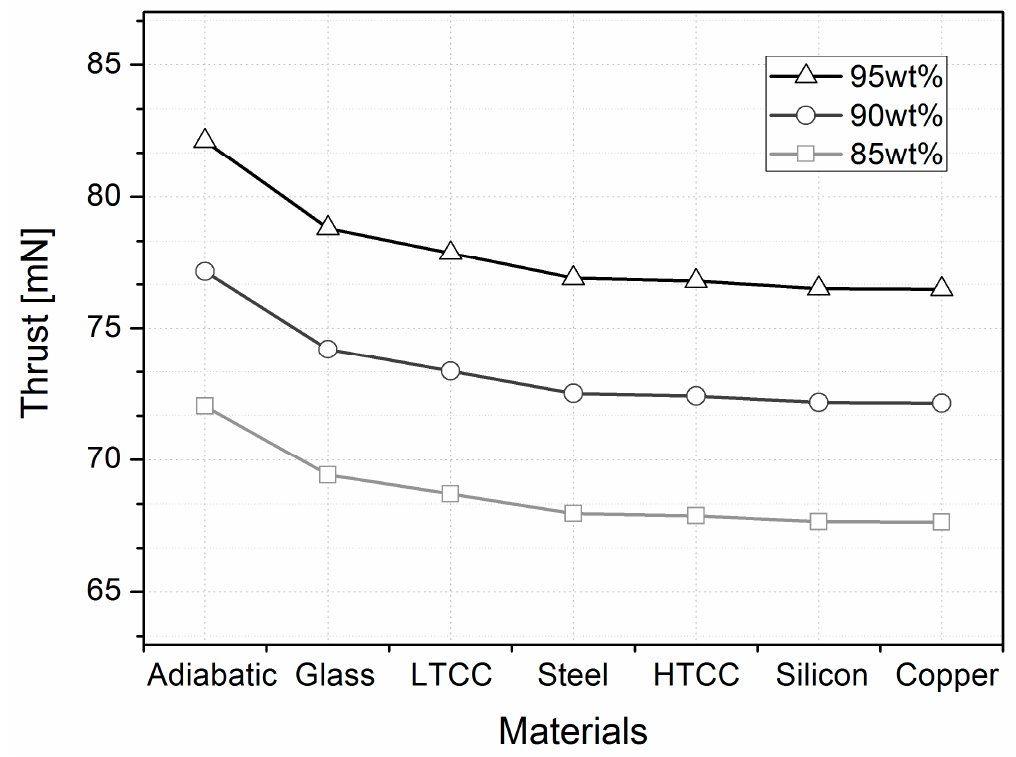
Figure 14. Estimated amount of thrust produced by microthrusters with different materials.